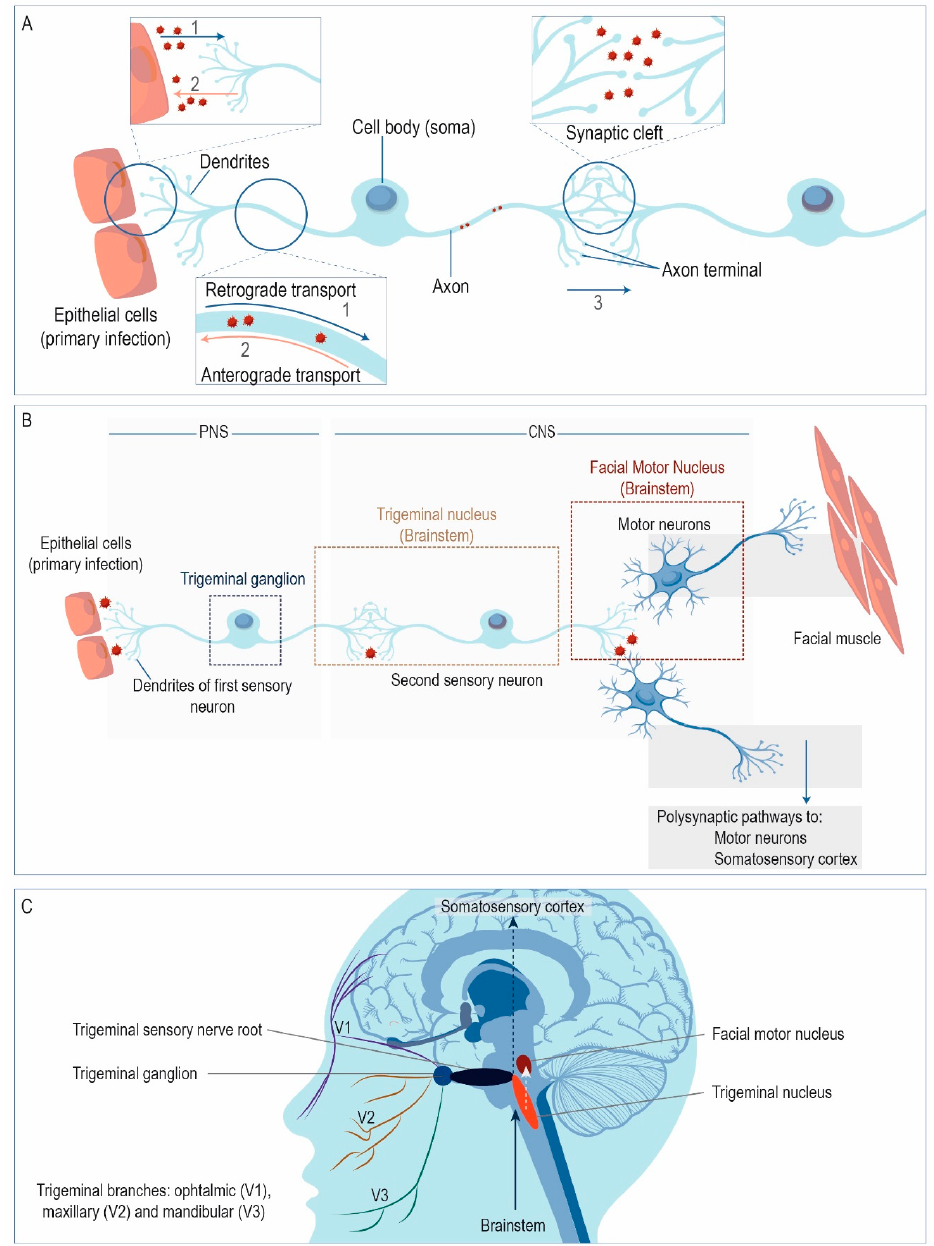
Figure 1. Spread of HSV-1 to the CNS via the trigeminal nerve. ( A ) HSV-1 may pass from the epithelia to the peripheral nervous system (PNS) by cell-to-cell spread between epithelial cells and nerve endings of sensory neurons that innervate them (1). The virus travels along the axon by retrograde transport to the cell soma of the sensory neuron, located in the trigeminal ganglion (TG). Conversely, HSV-1 can travel back by anterograde transport to the epithelial cells where the primary infection took place (2). The virus can also spread trans-synaptically, crossing the synaptic cleft (3). ( B ) After infection of epithelial cells, HSV-1 spreads to the PNS, entering sensory neurons by fusion with the plasma membrane of its nerve terminals. Then, HSV-1 travels retrogradely to the cell body and establishes a latent infection in the TG. Afterwards, the virus may enter the central nervous system (CNS) if it spreads trans-synaptically to the brainstem, from where it might spread to higher brain areas. ( C ) Spread to the CNS may take place through the three branches of the trigeminal nerve: ophthalmic, maxillary and mandibular. From here, the virus can access the trigeminal nucleus and other brain structures. (Structures are schematically represented and they are not drawn to